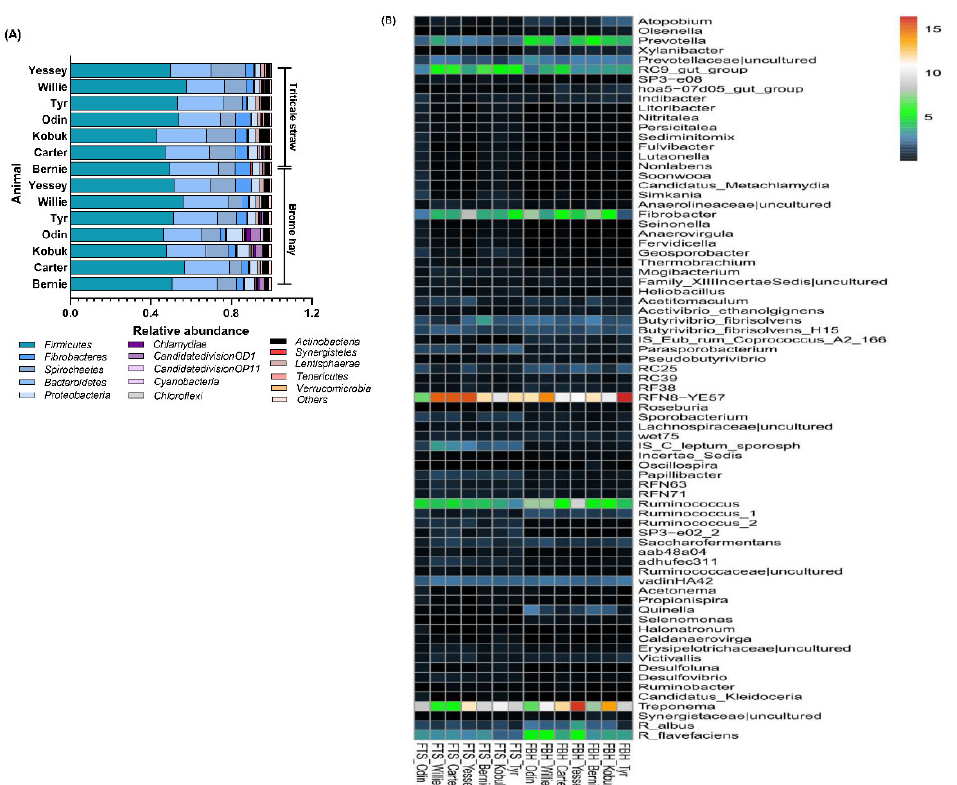
Figure 2. Bacterial phylotypes at the level of ( A ) phylum and ( B ) species in solid phase rumen con ‐ tents from 7 muskoxen in two groups crossover fed either triticale straw (TS noted) or brome hay (BH noted).